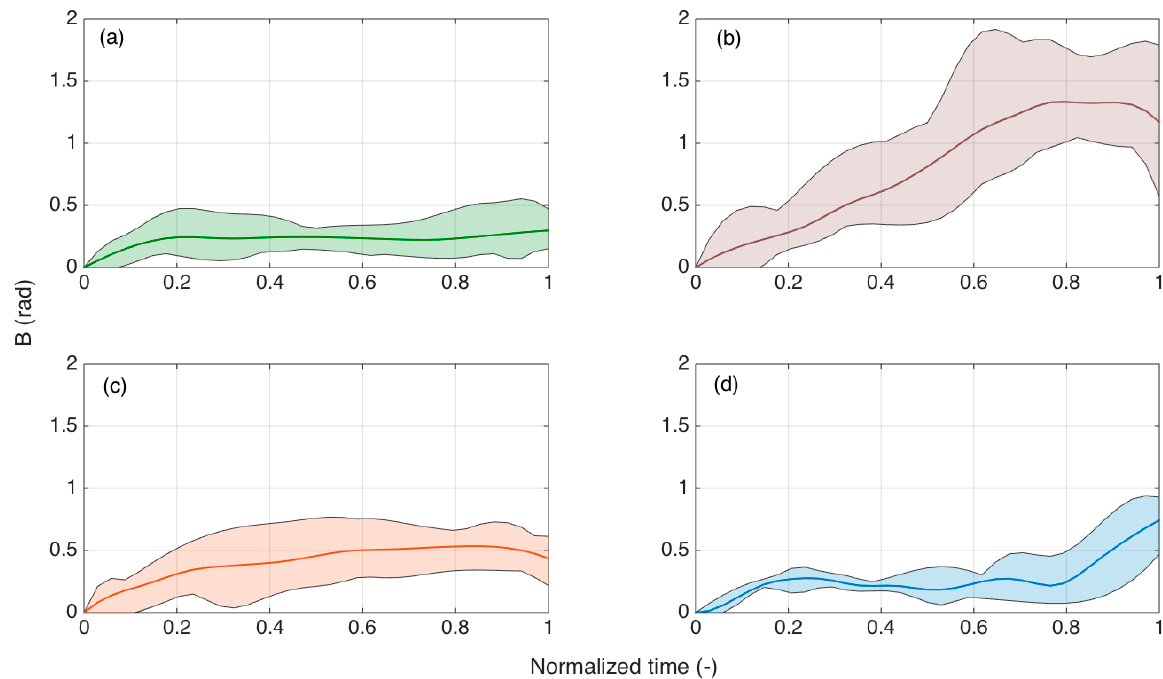
Figure 11. SPBA patterns reported over normalized time (0 = start of the insertion; 1 = end of the insertion). Solid lines show the mean B value for each normalized time reported for all the experiments showing a similar pattern to Figure 10. Shaded regions show the minimum and maximum values among all the experiments. ( a ) Straight insertion; ( b ) large curvature; ( c ) reduced bending; ( d ) failed insertions.